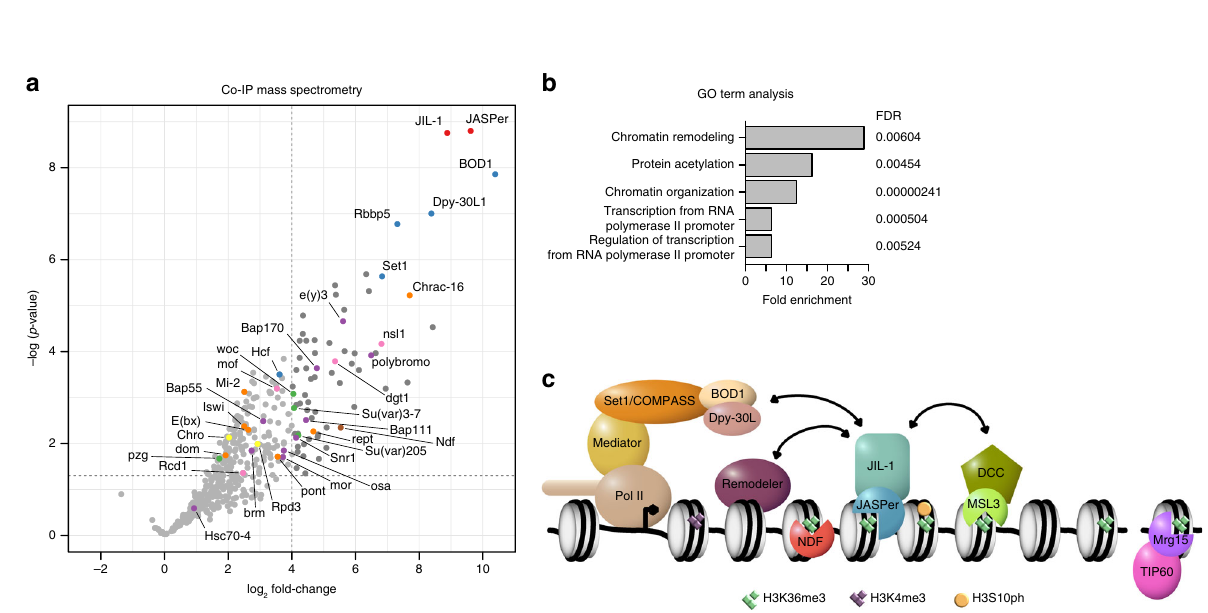
Fig. 7 The JASPer interaction network and other H3K36me3 binding proteins and complexes in Drosophila melanogaster . a Volcano plot of IP-MS showing – log α -JASPer IP ( n = 6) versus control IP ( n = 5). Signi fi cantly enriched ( p -value < 0.05 and log 10 ( p -values) against mean log 2 fold-change in 2 fold-change > 4) proteins ( n = 69) are highlighted in dark gray. JIL-1 and JASPer are marked in red, Set1/COMPASS complex members in blue, PBAP/Brm complex members in purple, other proteins involved in chromatin remodeling in orange, NSL complex members in pink, Su(var)3-7, Su(var)205, woc and pzg in green, Chro and Rpd3 in yellow and NDF in brown. b Bar plot showing GO term enrichment of signi fi cantly enriched proteins shown in a . The fi ve statistically signi fi cantly (fdr < 0.01) most enriched GO terms are shown. c Model of JJ-complex binding at H3K36me3 marked gene bodies and interactions with other complexes. Interactions presented here are indicated by arrows. Other known H3K36me3 binding proteins (NDF and Mrg15) are drawn at the lower side. We propose that phosphorylation by JIL-1 kinase is tightly regulated in space and time in part by its partner JASPer which stabilizes and anchores the kinase to active genes and telomeric transposons by binding to H3K36me3 nucleosomes via its PWWP domain. Regulation by JASPer affects any potential phosphorylation by JIL-1, in particular H3Ser10 phosphorylation which is involved in inhibition of